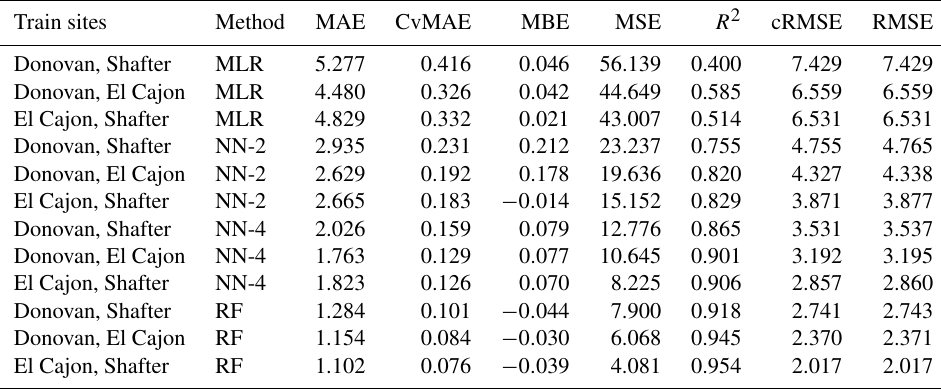
Table C9. Level 2 train results for NO 2 (train and test on the same data